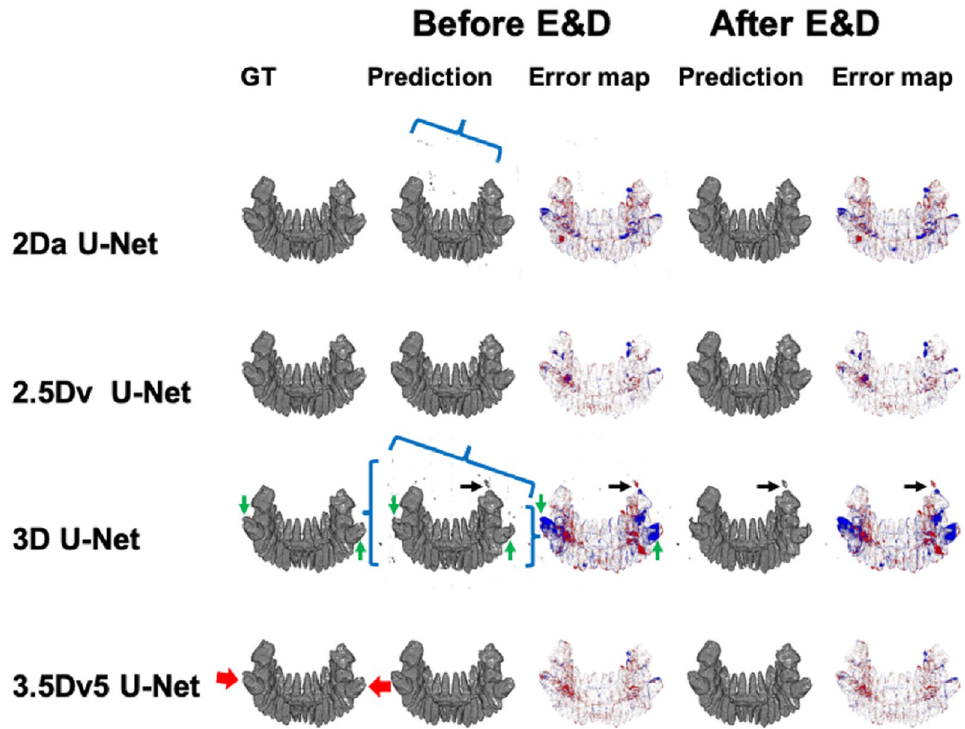
Figure 10. Illustration of ground truth, prediction, and error map in a patient with impacted mandibular third molar teeth (red arrows) before and after E&D in 2Da U-Net, 2.5Dv U-Net, 3D U-Net, and 3.5Dv5 U-Net. The 2Da U-Net and 3D U-Net show lots of tiny false positive results (blue brackets) which could be eliminated by either majority voting or E&D. In 3D U-Net, additional larger false positive results (black arrows), which are not reduced by E&D, are successfully eliminated via majority voting (2.5Dv U-Net and 3.5Dv5 U-Net). Some false negative results (green arrows), which are more apparently seen on 3D U-Net before and after E&D,